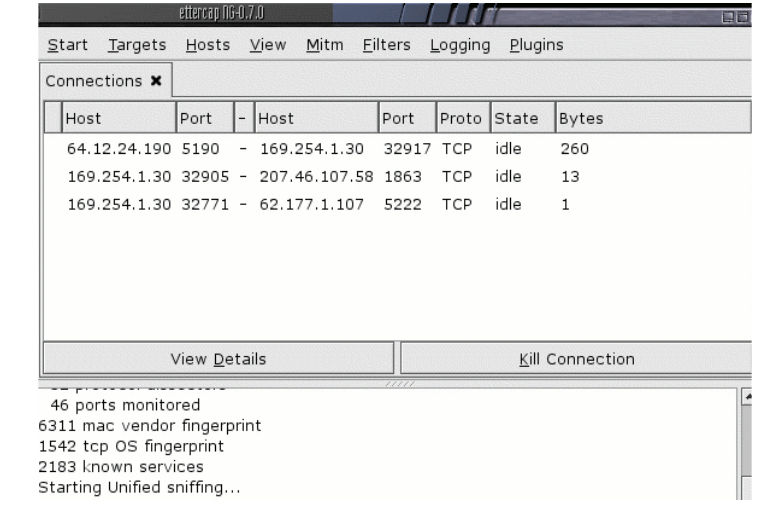
Figure 15 – Ettercap NG –